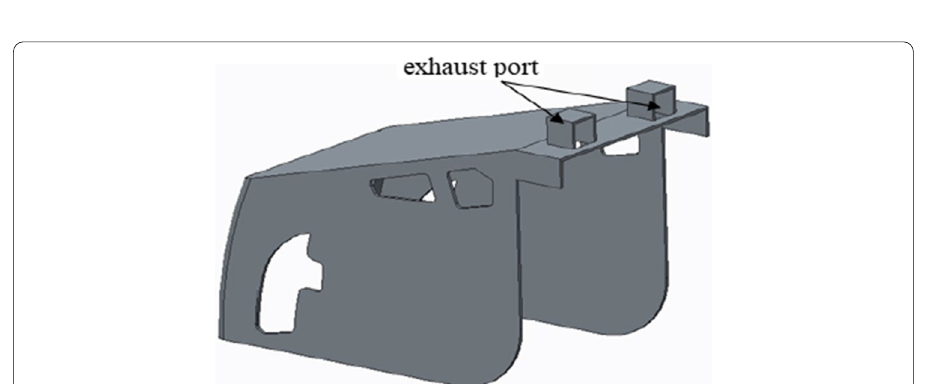
Fig. 6 Section speed vector at idle ( z